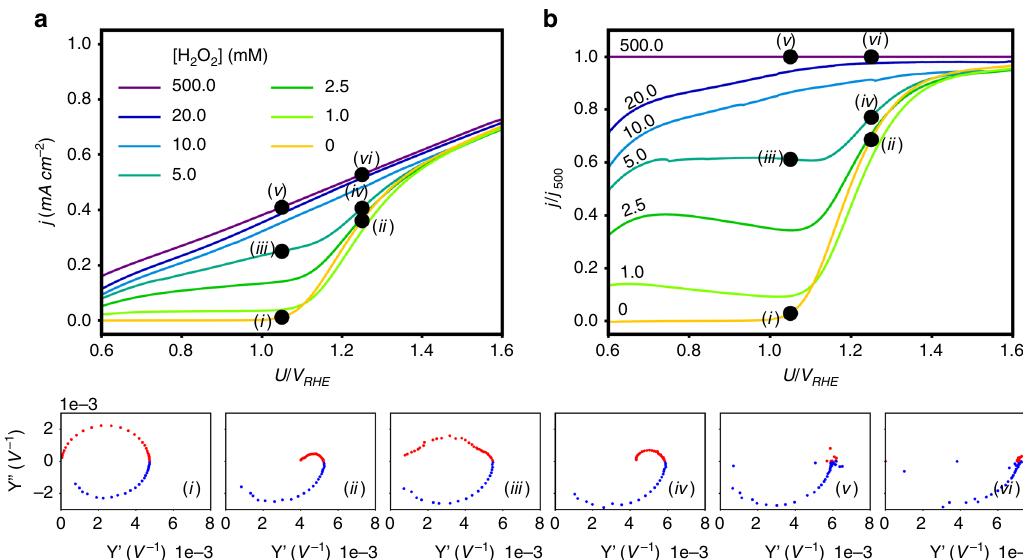
Fig. 1 Photocurrent voltammograms and intensity-modulated photocurrent spectra at varied H 2 O 2 concentrations. a Photocurrent density as a function of the applied potential under white LED illumination (80 mWcm − 2 ) at different H 2 O 2 concentrations as indicated in the legend. b Normalized photocurrent voltammograms obtained by dividing the photocurrent voltammograms in a by the photocurrent measured at [H 2 O 2 ] = 500 mM, j 500 . Bottom IMPS spectra correspond to: (i) [H 2 O 2 ] = 0 mM, U = 1.05 V RHE , (ii) [H 2 O 2 ] = 0 mM, U = 1.25 V RHE , (iii) [H 2 O 2 ] = 5 mM, U = 1.05 V RHE , (iv) [H 2 O 2 ] = 5 mM, U